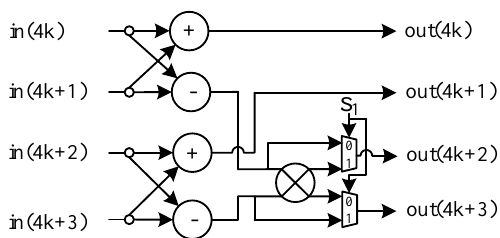
Figure 4. Architecture of the k th sub-PE.